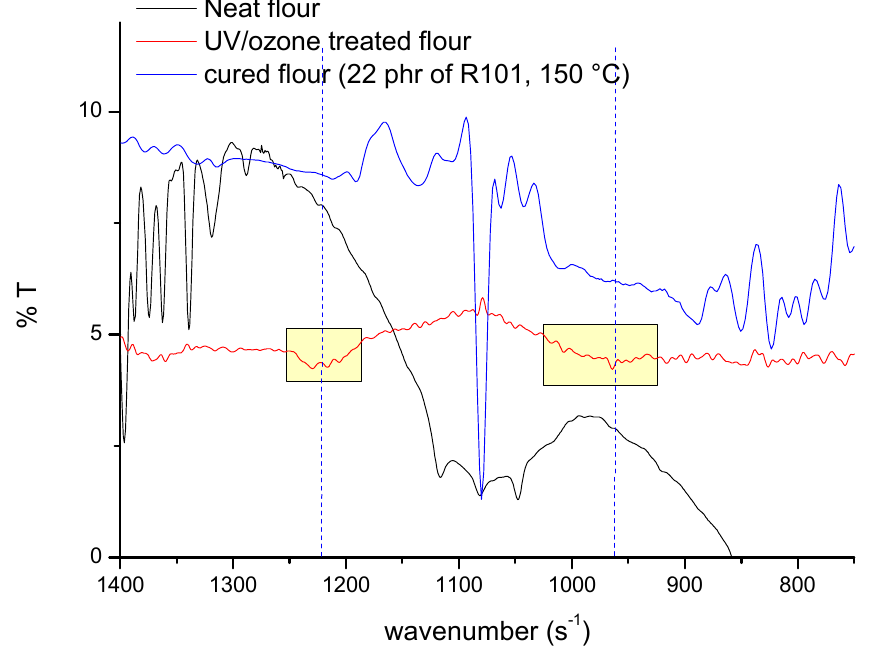
Figure 3. FTIR spectra of waste flour.